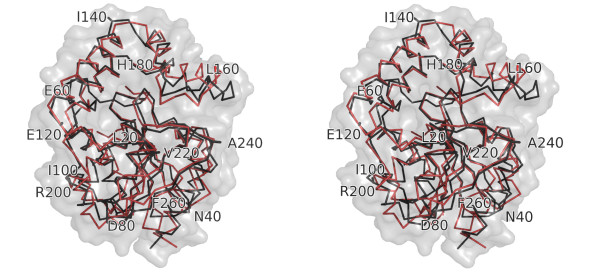
Overlay of SaMenH and VcMenH. A stereoview of the Cα trace of MenH from two species. SaMenH is depicted as a semitransparent van der Waals surface (gray) with Ca trace as black sticks. The Ca trace of VcMenH is shown as red sticks.